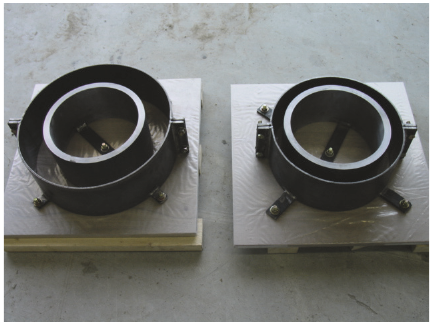
Figure 2: Ring test molds (left: 76 mm ring; right: 35 mm